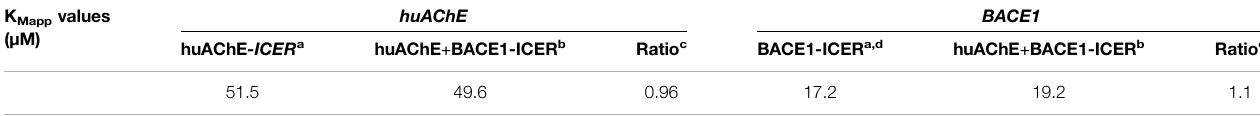
a Individual-system. b Dual-system.